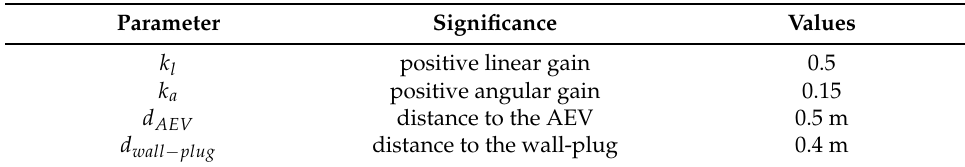
Table 1. Experimental parameters.